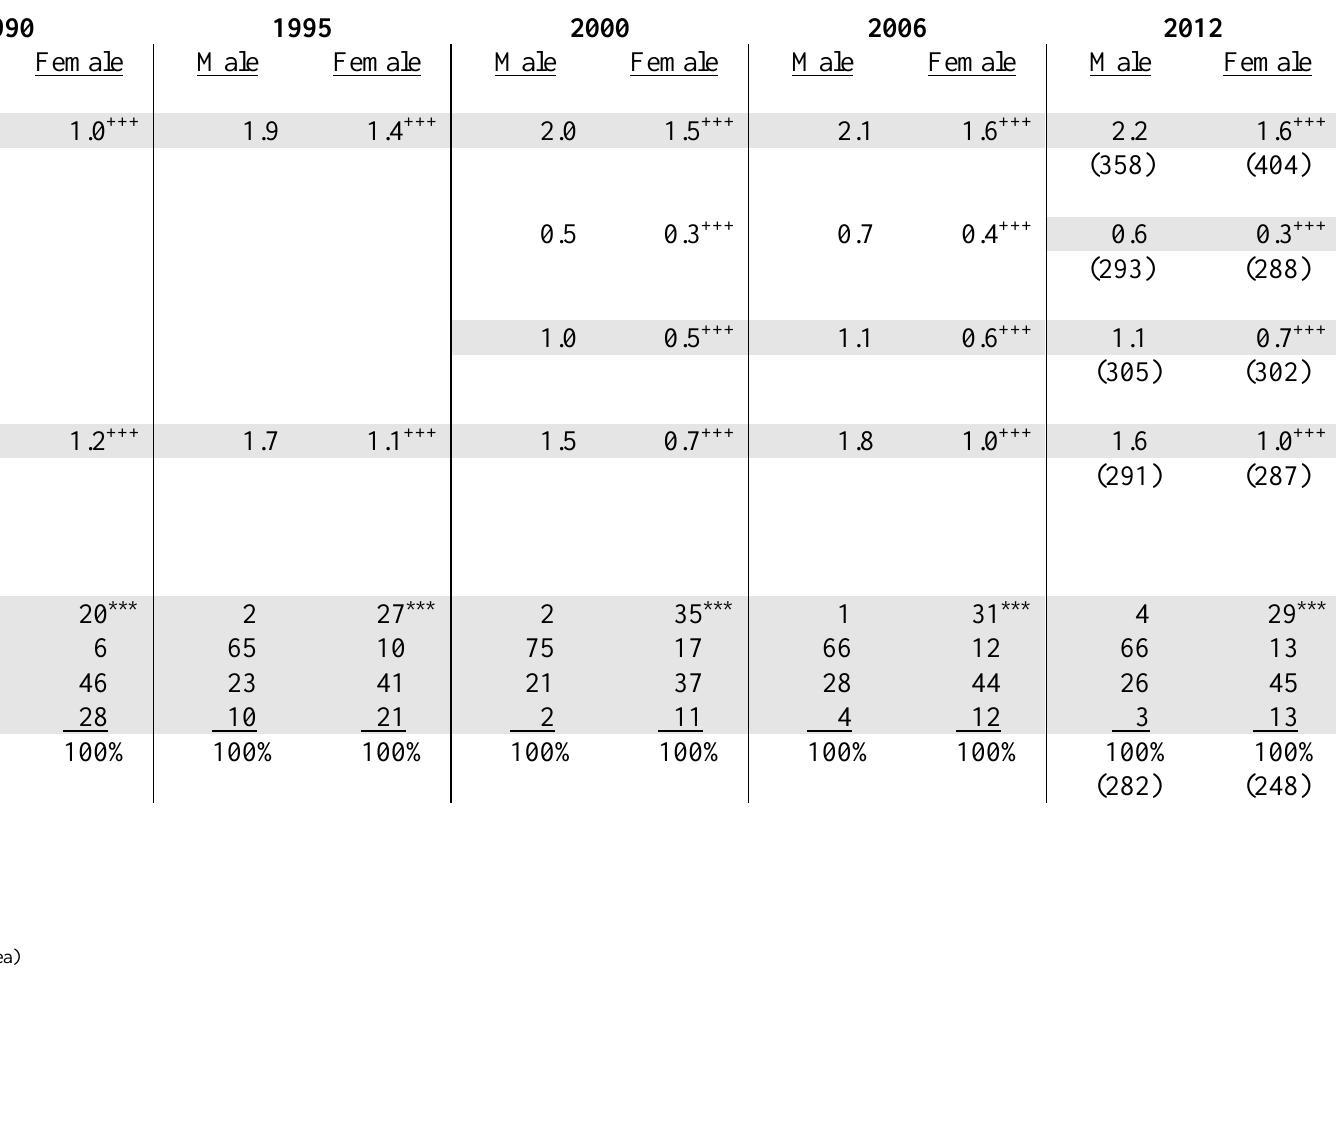
Table 19. Children and Child